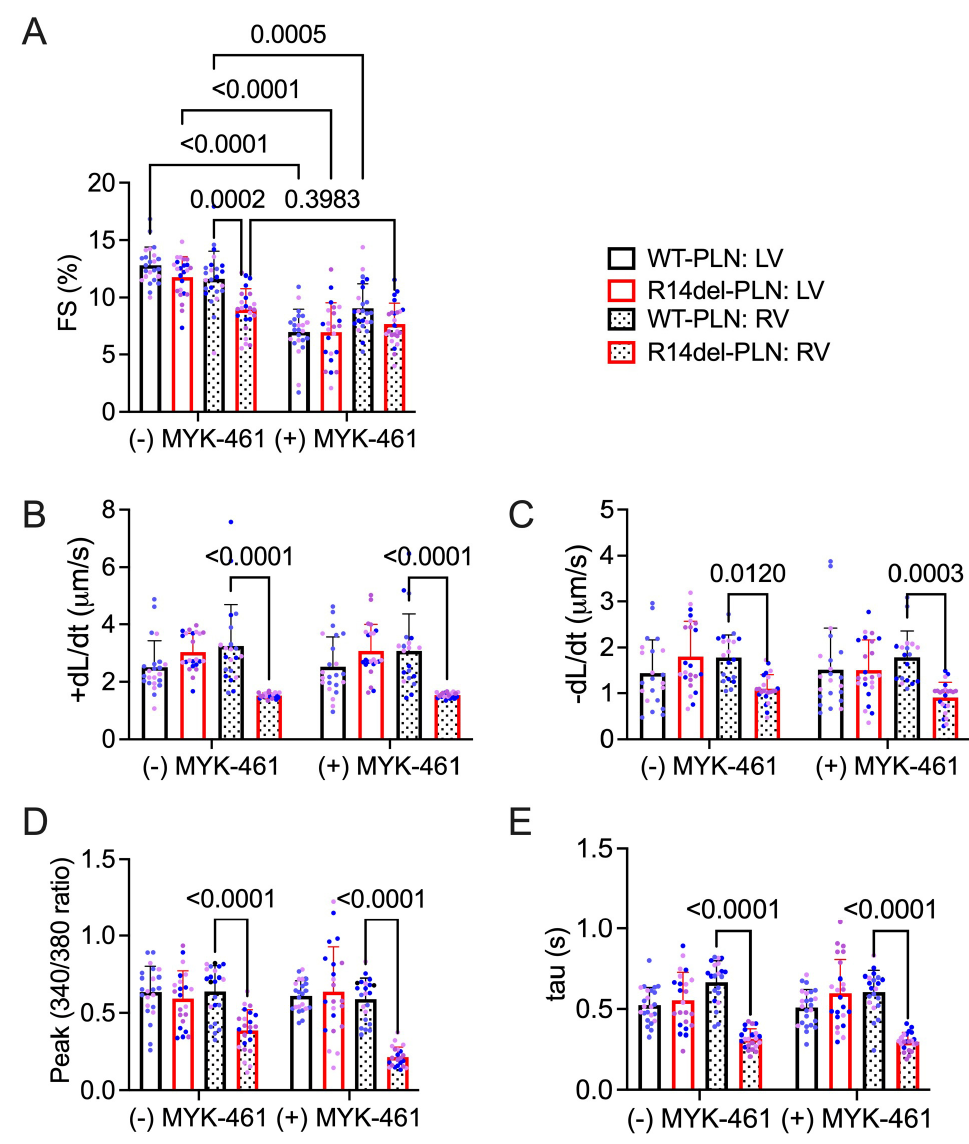
Figure 3. The myosin inhibitor MYK-461 depresses contractility with no effect on calcium handling. ( A ) Fractional shortening (FS) in the absence and presence of 250 nM MYK-461 at 0.5 Hz. ( B ) Con- traction velocity of sarcomere in the absence and presence of MYK-461. ( C ) Relaxation velocity of sarcomere in the absence and presence of MYK-461. ( D ) Ca 2+ transient amplitude as indicated by the Fura-2 ratio (340:380 nm) in the absence and presence of 250 nM MYK-461 at 0.5 Hz with 1.8 mM Ca 2+ and ( E ) the relaxation time constant (tau) of calcium transient in the absence and presence of MYK-461. N = 3 hearts (20–22 cells)/group. Blue and pink dots represent male and female data points, respectively. Data are expressed as mean ± SD, and statistical analyses were performed in all groups using ordinary two-way ANOVA followed by Tukey’s multiple comparison test.